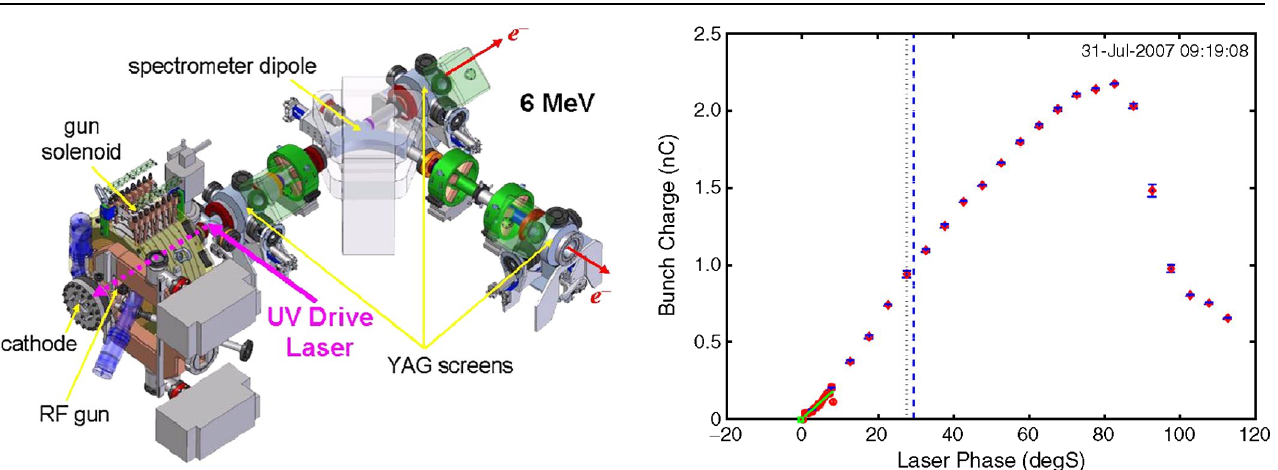
FIG. 8. (Color) An example Schottky scan where the laser phase is varied and the bunch charge measured. The phase is set 30 degS from the zero-crossing point (at 0). The initial phase (before the scan) is shown as a dotted vertical line and the new phase (after the scan) is shown as a dashed blue vertical line.